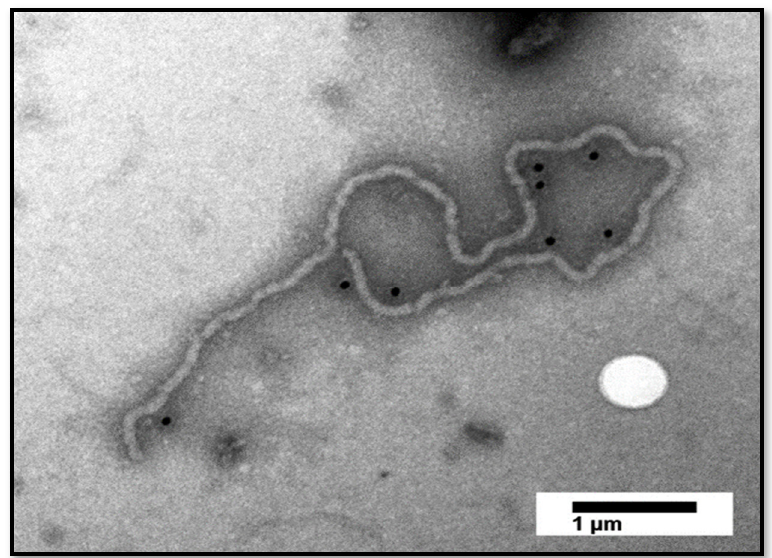
Figure 3. Transmission electron micrograph of immunogold-labeled citrus tristeza virus (CTV) particles purified from a composite sample of Asian citrus psyllids, using antibodies against the major coat protein (CTV-CP). Scale bar = 1 µm.